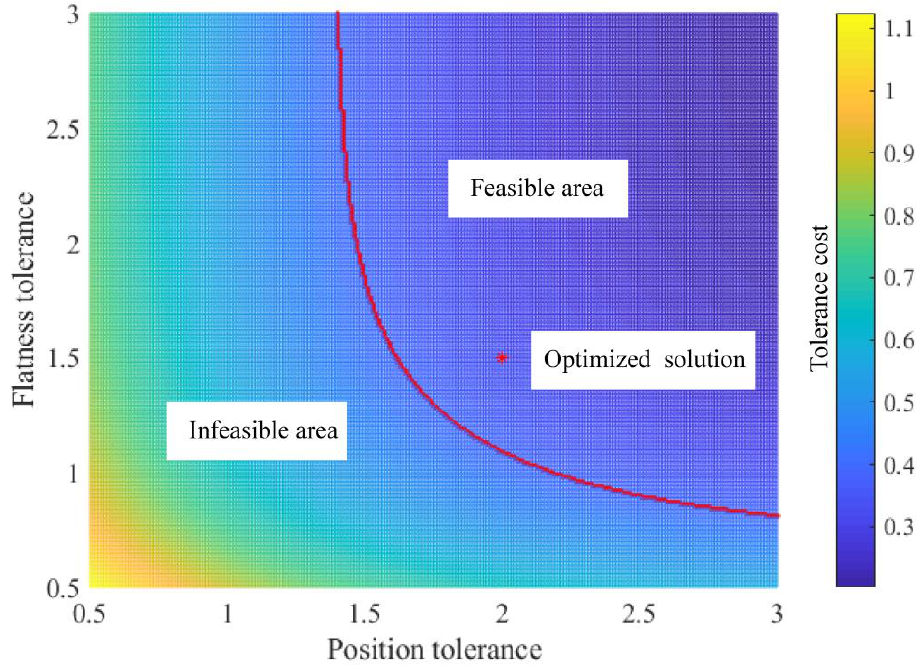
Figure 11. The feasible hybrid tolerances area defined by Equation (32). Table 1. The expectation of the maximum power density degradation. Flatness of the Reflection Plate (mm) Expectation